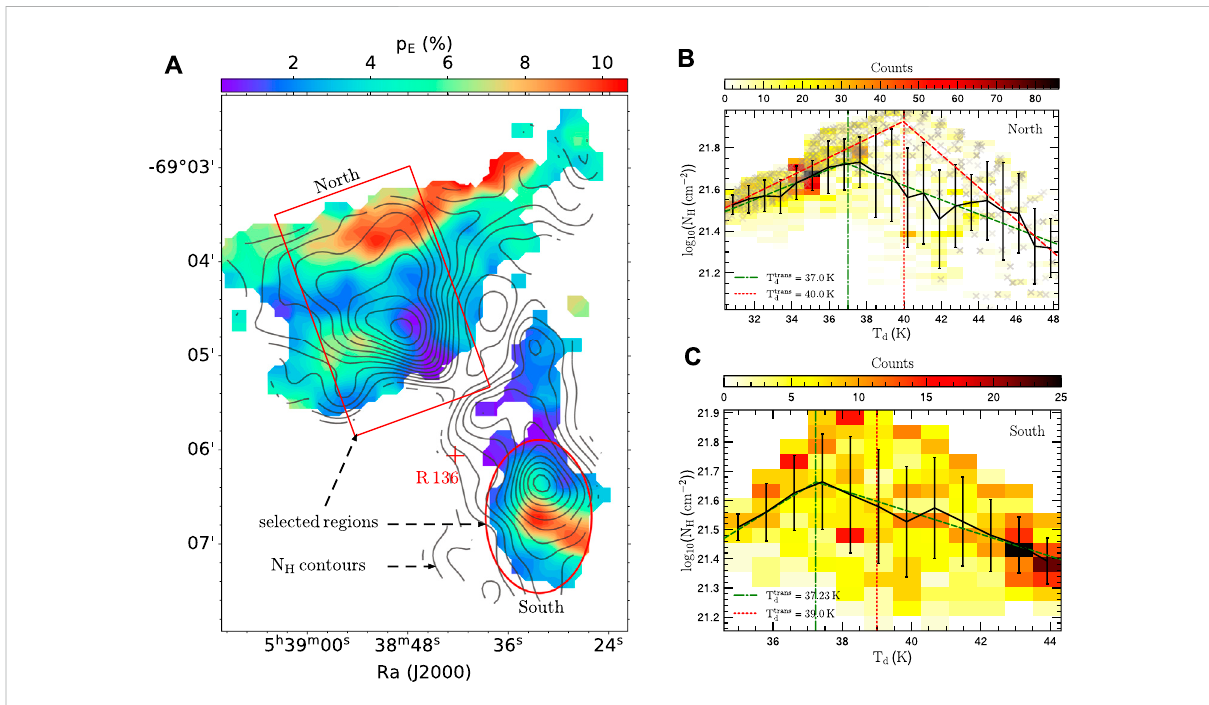
FIGURE 9 (A) SOFIA/HAWC + observations of 30 Dor at 214 μ m. Contours are the map of gas column density. The stellar cluster R 136 is located by a red cross. We selected two sub-regions, namely, north and south, to further analysis. (B,C) 2D-histogram of gas column density vs. dust temperature in two selected sub-regions: north and south. The black line shows the weighted mean in each bin associated with 1 − σ uncertainty. The blue line is a double power-law fi tting. In the north, we fi t to an upper envelope of thedistribution by adashed red line. In thesouth, the plot ismore scatter. However, these quantities are positively correlated upto T d ≃ 37 K and negatively correlated to higher T d . Figure adopted from Tram et al.,